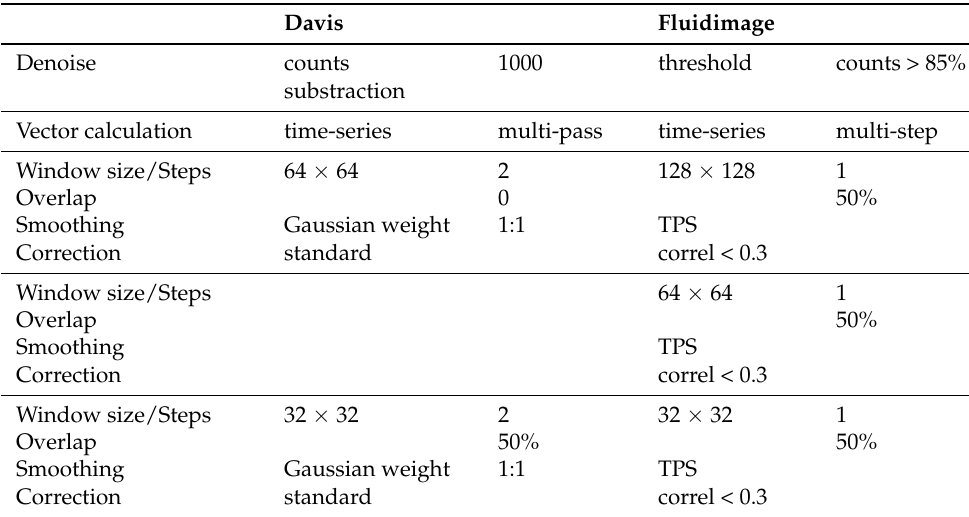
Table 3. DaVis and Fluidimage software settings used in the post-processing. Thin-plate-spline (TPS) stands for thin-plate spline interpolation.